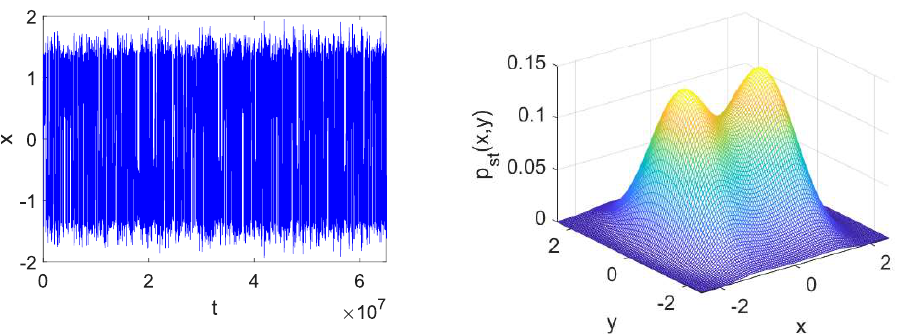
Figure 12. Same as Figure 11 for medium noise intensity.